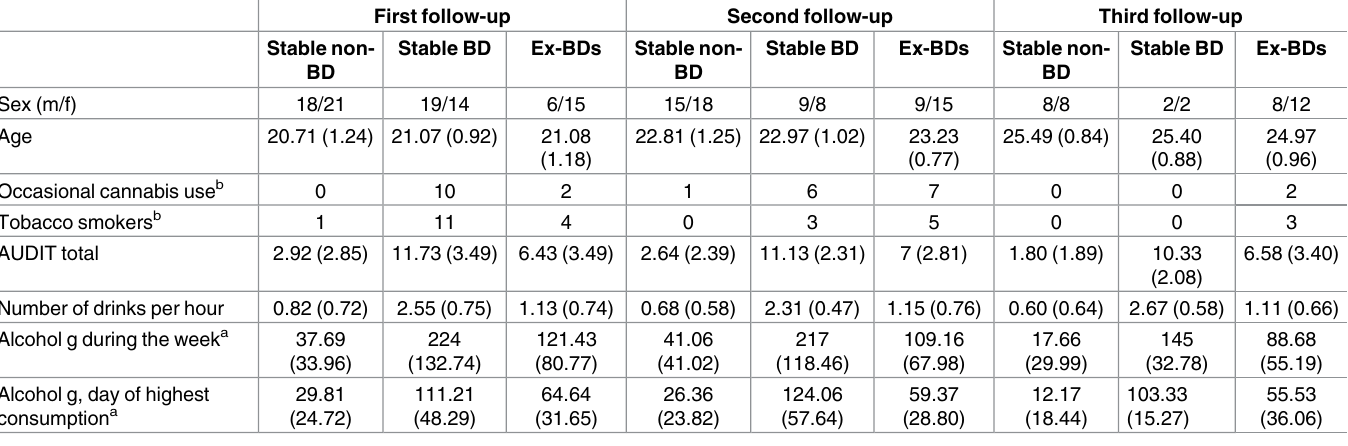
Table 2. Group means (standard deviation) for demographic and clinical data over